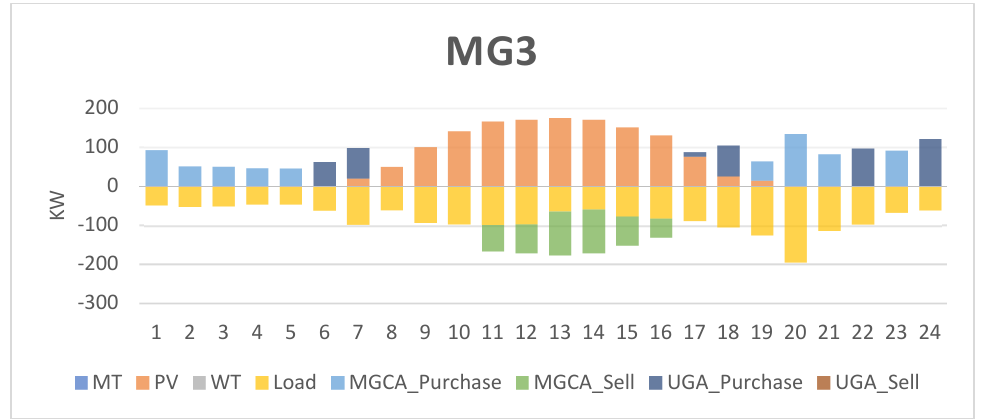
Figure 12. Change in the production power of each unit and the power bought and sold in microgrid 2.